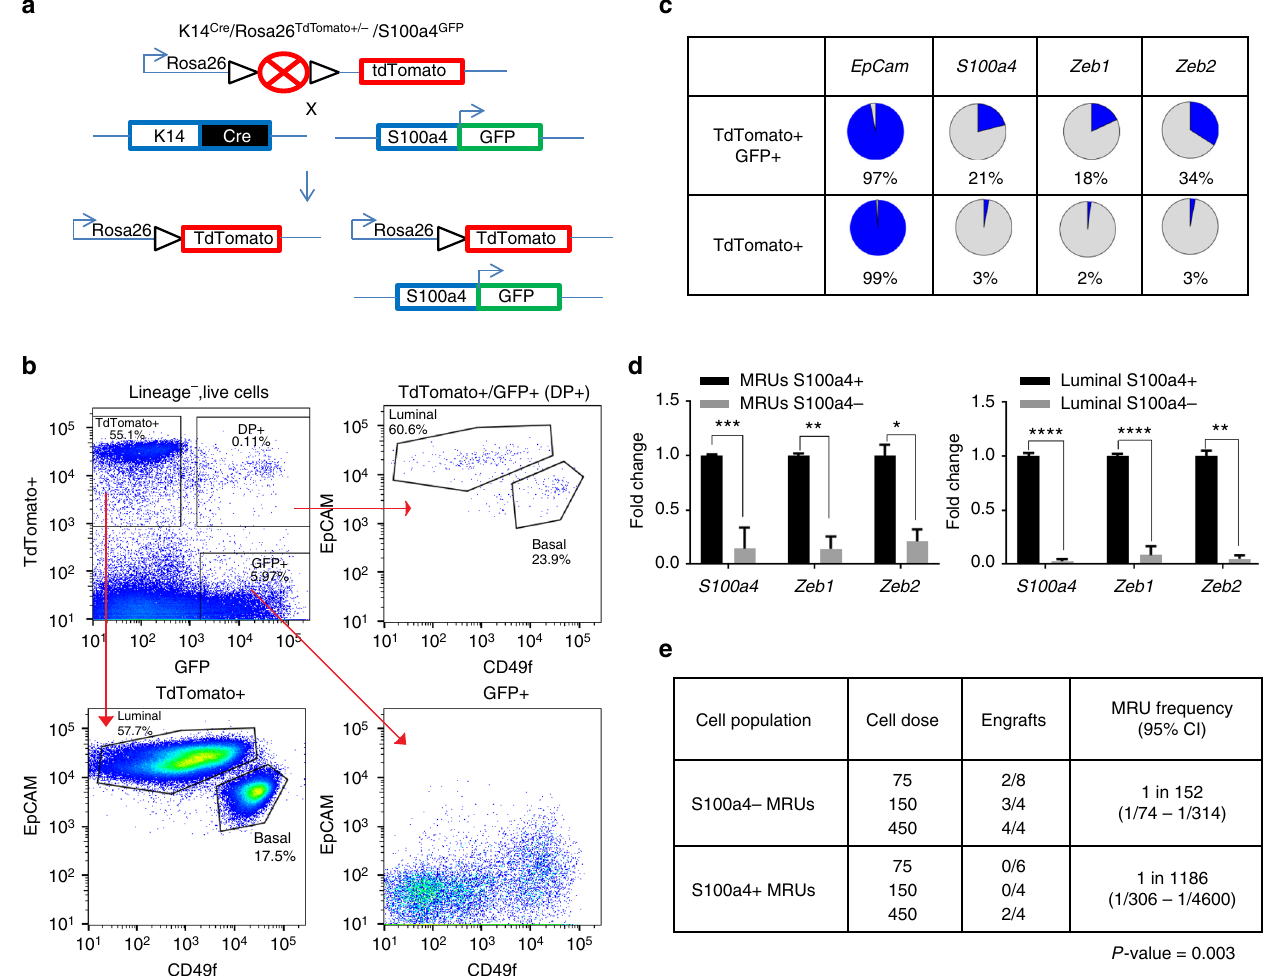
Fig. 1 Keratin 14+/S100a4+ cells express genes associated with EMT. a Schematic diagram showing the generation of the K14 Cre /Rosa TdTomato /S100a4 GFP mouse. K14 Cre marks all epithelial cells TdTomato+, while S100a4 dynamically controls expression of GFP. b FACS analysis of the K14 Cre /Rosa TdTomato / S100a4 GFP mouse mammary cells. The cells are gated on lineage − (CD45 − , CD31 − , Ter119 − ), DAPI − cells. TdTomato+, GFP+, or TdTomato+/GFP+ double positive (DP) cells are then analyzed using EpCAM and CD49f. TdTomato+ and DP cells are present in both luminal and basal lineages. Note: TdTomato + cells are at the chart edges to allow for adequate separation from DP cells. ( n = 6 mice). c Gene expression in single, FACS-isolated TdTomato+/GFP+ and TdTomato+ basal cells were analyzed by qRT-PCR. The results (Supplementary Fig. 1) are summarized here as the percentage of single cells analyzed that express the indicated genes. See Supplementary Fig. 1a for raw data and Supplementary Fig. 1b for expression values of individual genes and p -values. d Real time gene expression analysis of S100a4 , Zeb1 , and Zeb2 in S100a4+ and S100a4 − MRUs and luminal cells ( n = 3 mice sorted for different populations). The data are shown as mean ± SD. * p < 0.05, ** p < 0.01, *** p < 0.001, **** p < 0.0001 ( t -test). e S100a4+ MRUs and S100a4 − MRUs were sorted from 10 – 12-week-old nulliparous mice and used in transplantation assays in 3-week-old recipient mice. The data are combined from two independent transplant experiments ( p = 0.003, frequencies and p -values are calculated using ELDA